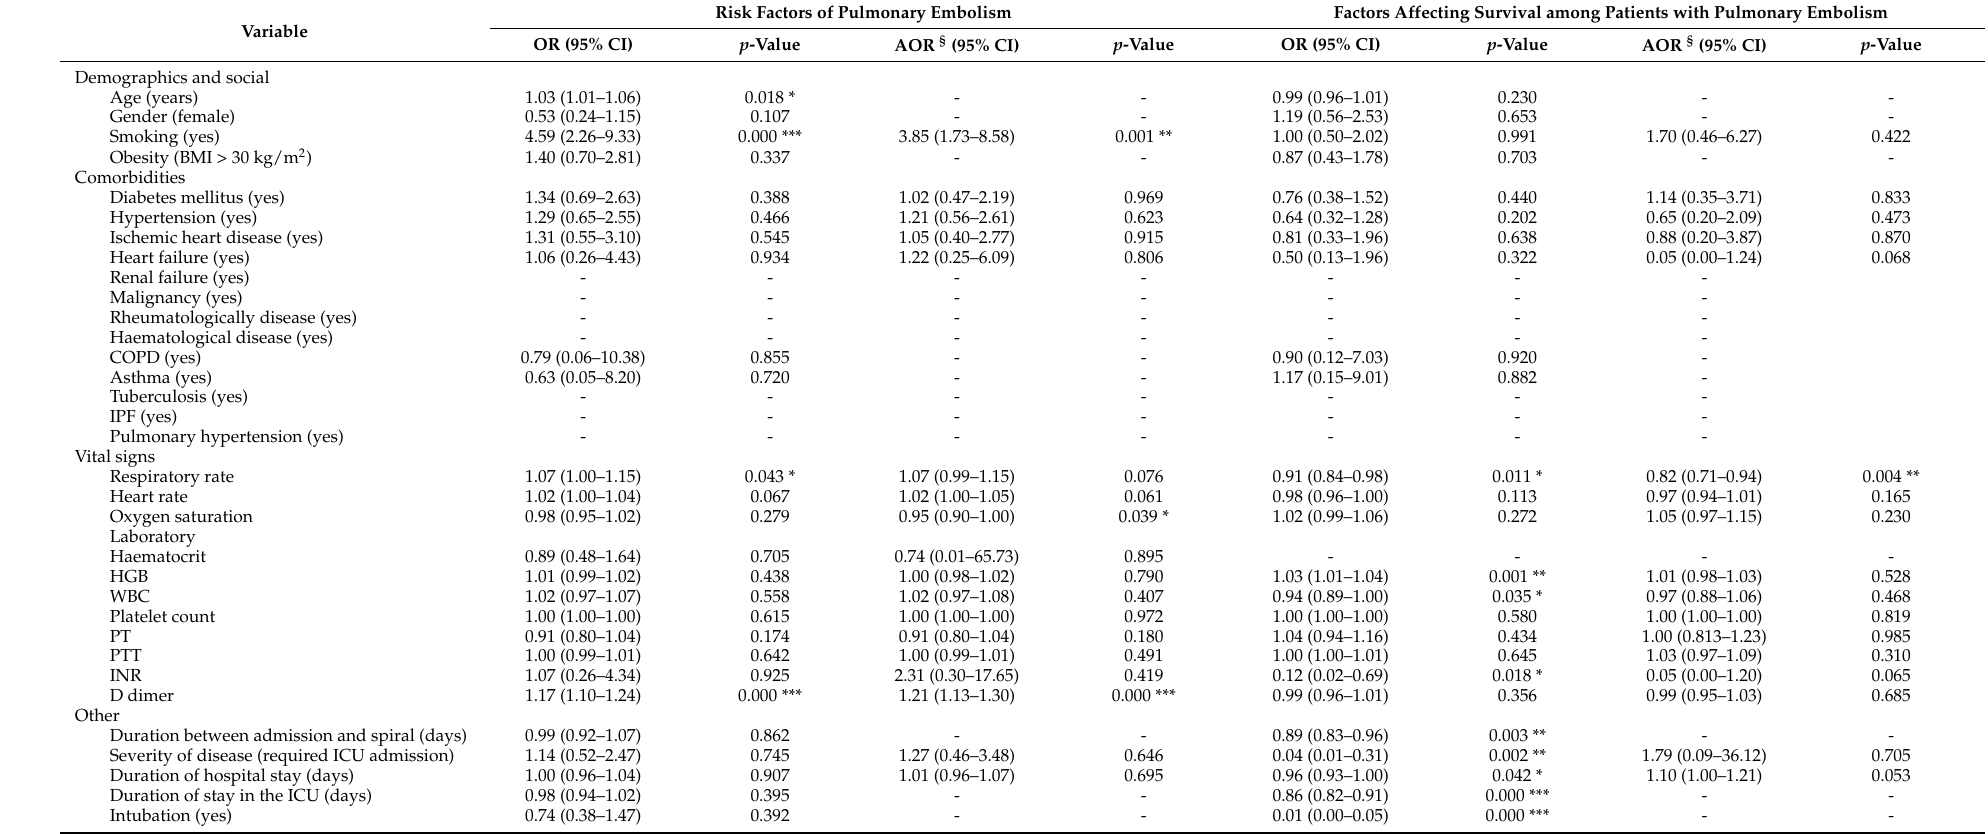
Table 4. Risk factors of pulmonary embolism and its